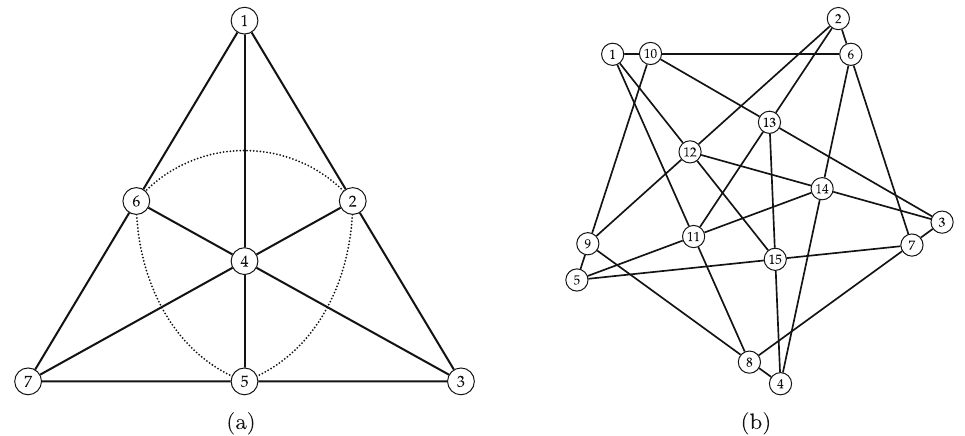
Figure 1: ( a ) The Fano 7 3 - con fi guration and ( b ) the Cremona - Richmond 15 3 - con fi